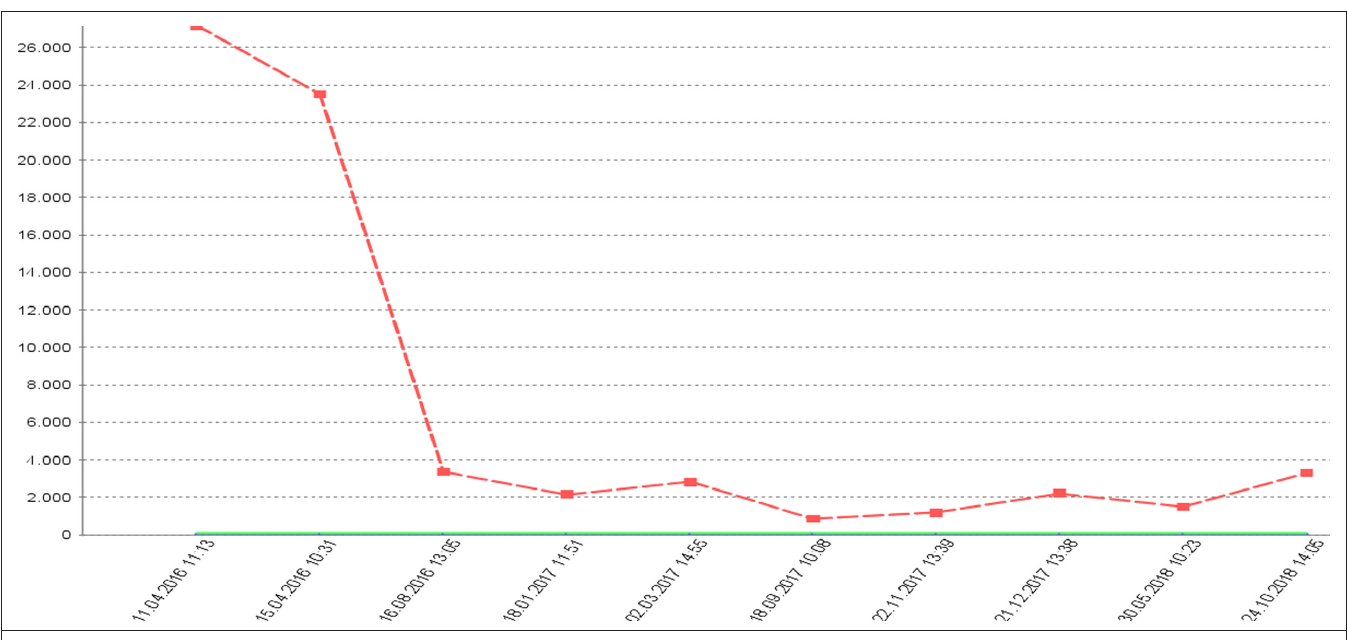
Figure 2. Case 2 Decrease of proteinuria levels after eculizumab